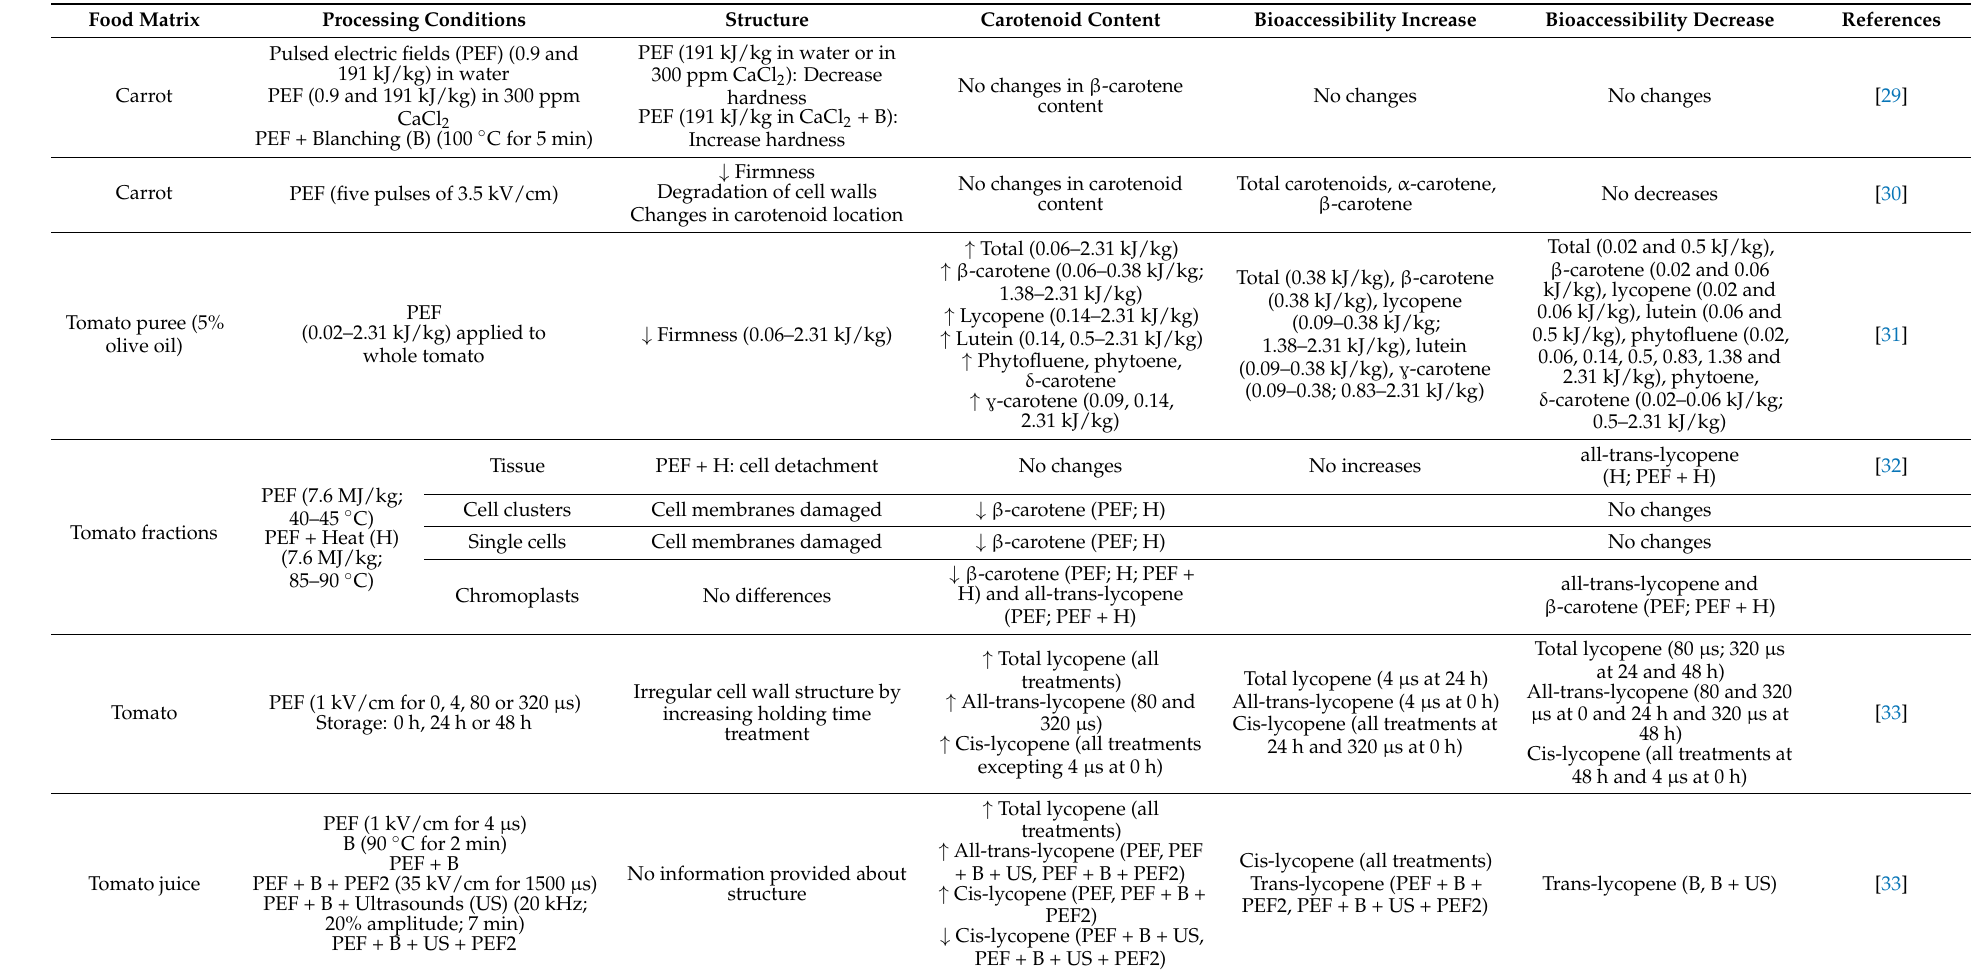
Table 1. Carotenoid content, bioaccessibility, and structure of selected plant foods as affected by non-thermal